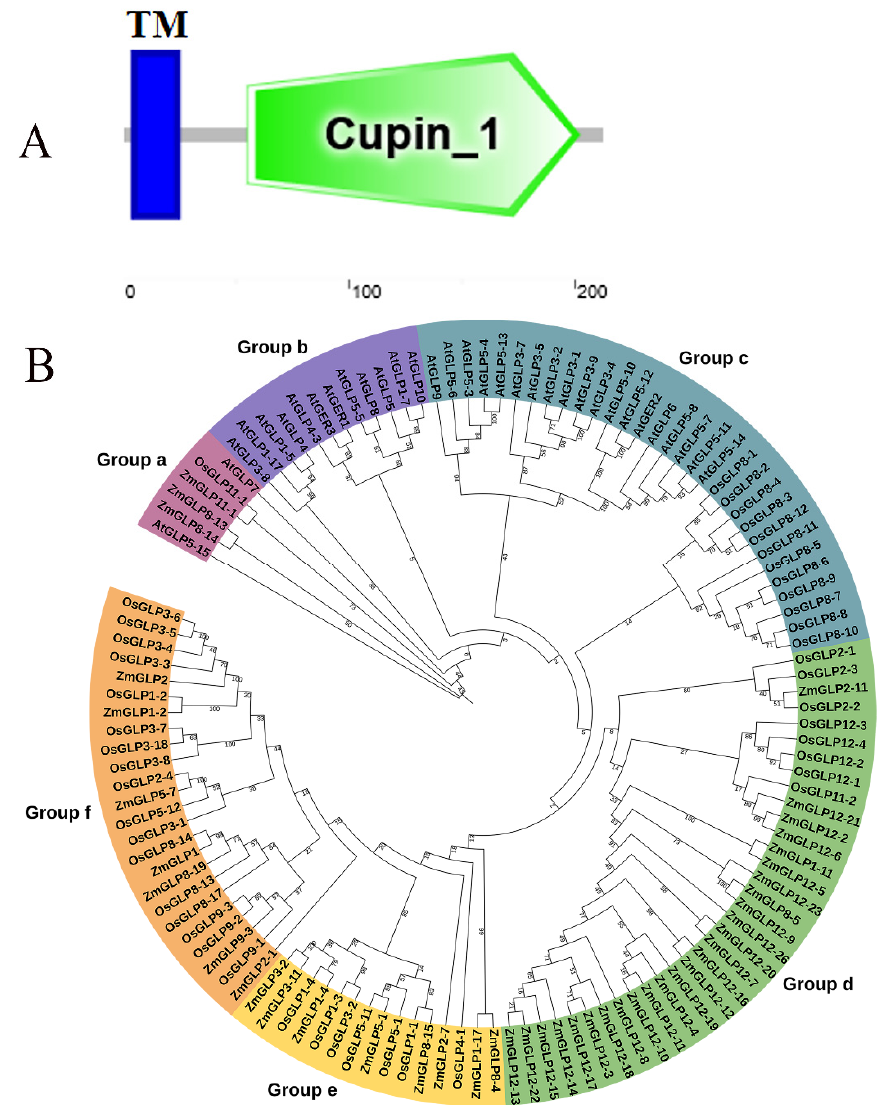
Figure 1. Characteristic analysis of ZmGLP1 . ( A ) The conserved domain analysis of ZmGLP1 . ( B ) Phylogenetic analysis of GLP s gene family from At ( Arabidopsis thaliana ), Os ( Oryza sativa ), and Zm ( Zea mays ). GLP genes are divided into 6 categories. ZmGLP1 is marked in red. Bootstrap values of 1000 replicates are shown as percentages at the branch nodes. Bar = 0.1. Subfamilies are represented by orange, yellow, green, blue, bluish-purple, and purple branch lines.